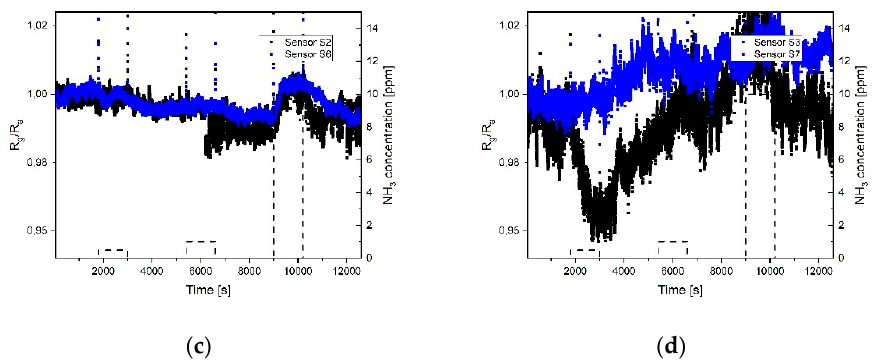
Figure 10. Dynamic response of the sensors toward different concentrations of NH 3 (0.5, 1, 10 ppm): ( a ) Sensors S 0 and S 4 , ( b ) sensors S 1 and S 5 , ( c ) sensors S 2 and S 6 , ( d ) sensors S 3 and S 7 . The temperature of the heater underneath the sensor was 250 °C and the relative humidity in the test cell was 20% (at room temperature).